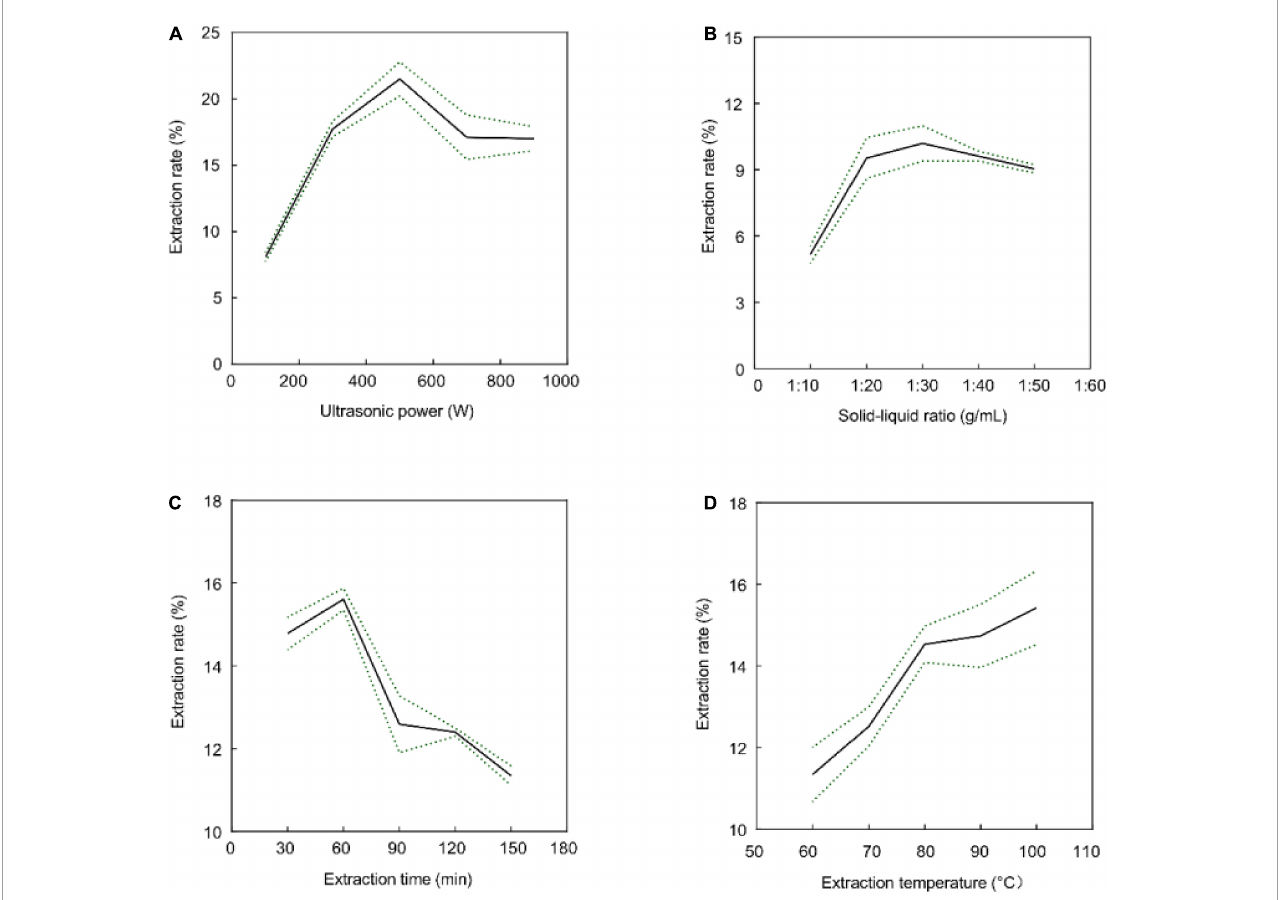
FIGURE1 Effects of extraction time (A) , ultrasonic power (B) , solid-to-liquid ratio (C) , and extraction temperature (D) on the extraction rate of crude GFP. Data are expressed as the mean ± SD ( n = 3). All the data between groups were statistically significant ( P <